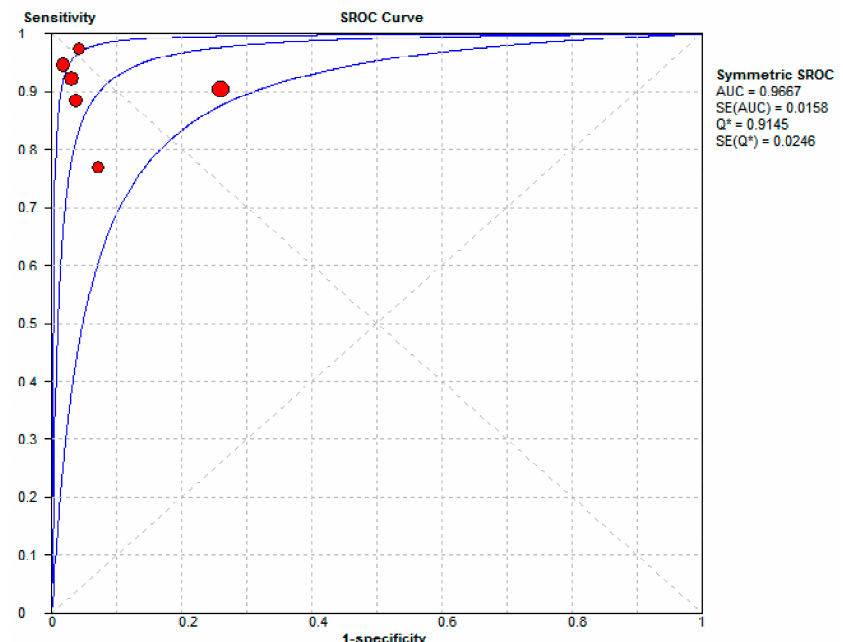
Figure 3. Diagnostic performance of urinary calprotectin on discriminating between intrinsic acute kidney injuries and prerenal acute kidney injury.